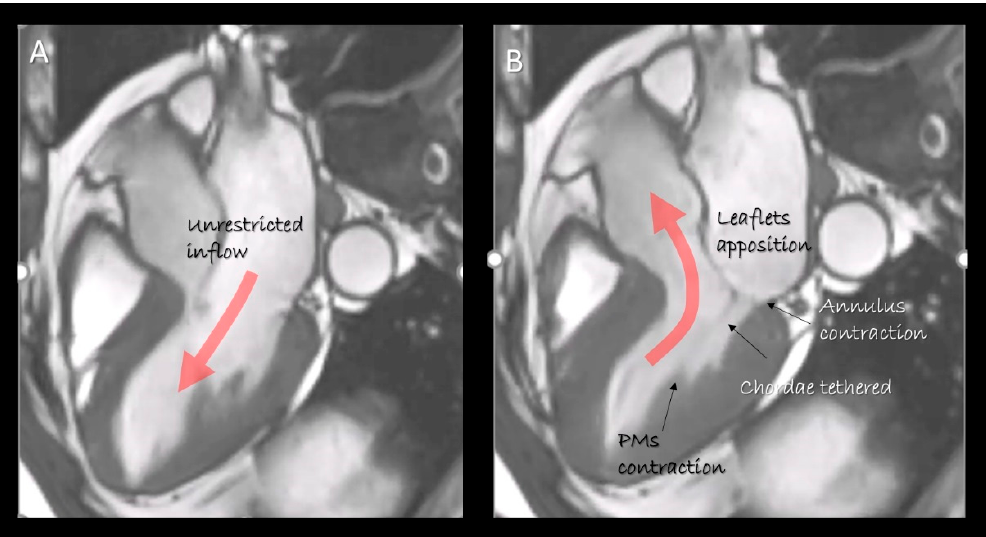
Figure 1. Cardiac magnetic resonance (CMR) still frame image in cross-section long-axis view in ( A ) diastole and ( B ) systole showing the mitral valve apparatus formed by leaflets, annulus, chordae tendinea and papillary muscles. They move in a perfect spatial and temporal coordination to obtain an effective competence and an unrestricted inflow. The “dynamic” anatomy provided by non-invasive imaging techniques gives us the awareness as the structural arrangement of any single component serves to a specific function.